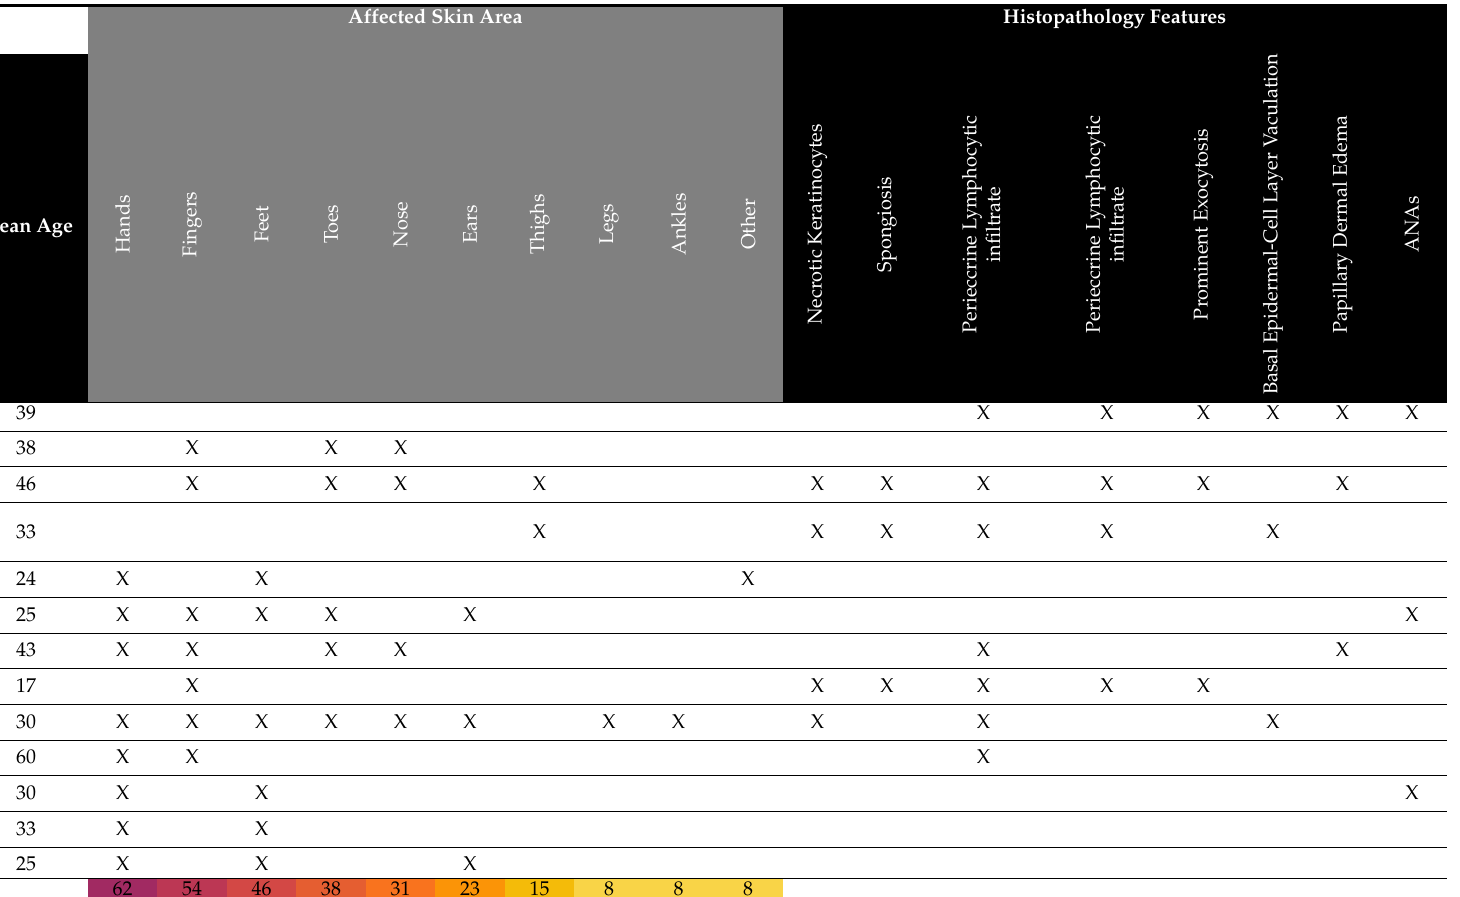
Table 1. Characteristics and available data of the included